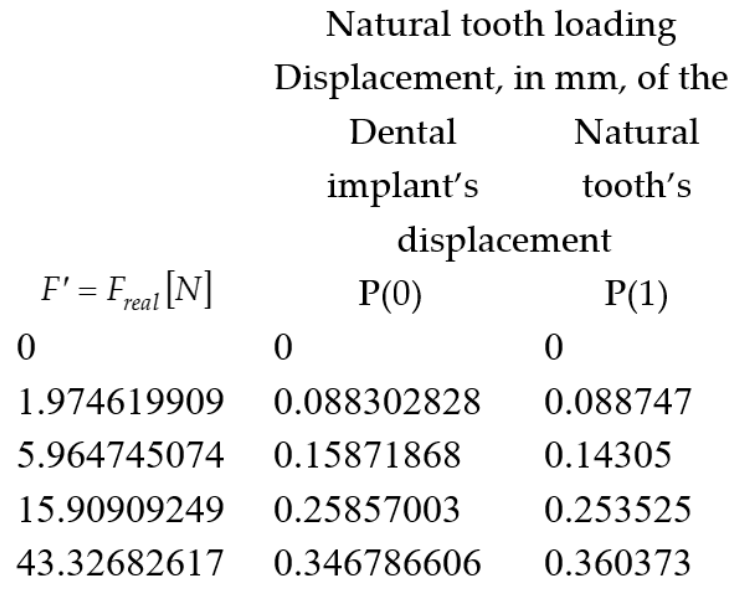
Figure 12. The relative displacements of the crowns during the natural tooth’s loading. 4. Discussions Results clearly show that the micro-movement pattern of the dental implant and the normal tooth show great differences. Approximately similar in vivo experiments pro- duced the same results [5]. The linear displacement type of the dental implant refers to the linear elastic modulus of bone tissue in the case of normal bite forces, up to approx- imately 50 N [23]. This elastic modulus differs greatly in the case of cortical and spongy bone type. The thickness and proportional distributions of these two bone types define the mechanical properties for each region of the jaws [24]. In our case, absolute values of the micro-movements of the dental implants are defined by the characteristics of this re- gion of the upper jaw, consisting of soft spongy bone, covered by thin cortical bone, re- duced much in height by the presence of the maxillary sinus. It seems that the major in- fluencing factor regarding the type and value of implant micro-movement is defined by